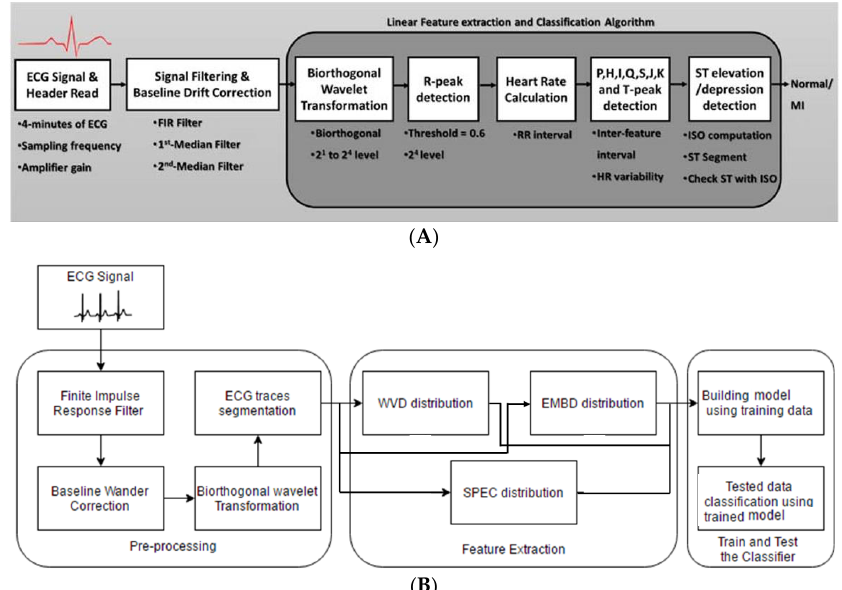
Figure 7. Blocks of the linear classification ( A ) and machine learning (ML) ( B ) based MI detection algorithm.